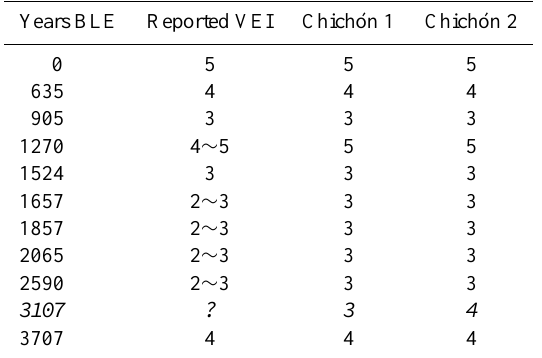
Table 3. Two possible models of the VEI magnitude distributions for eruptions with magnitude VEI ≥ 3 of El Chich´on volcano dur- ing a period of 7772years BLE. The second column reproduces the reported VEI values listed in Table